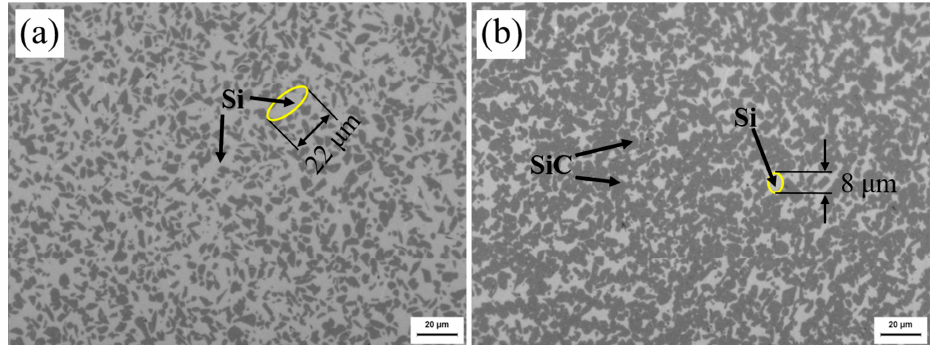
Figure 9. The microstructure of RB-SiC for: ( a ) P0F0, ( b ) P20F80. The bulk density of SiC is obviously higher than Si. Therefore, the bulk density of RB-SiC would definitely be increased with the increase in SiC content. Comparing P10F90 with P0F0, the impregnation method increased the density of RB-SiC by 6.6%. When the concentration of PF was 20 wt.%, the density of P20F80 reached the maximum with a value of 2.94 g/cm 3 . However, the bulk density of P30F70 was only 2.86 g/cm 3 , as shown in Fig- ure 10a. Due to the limited solubility of PF in FA, when the concentration of PF was 30 wt.%, the viscosity of the composite precursor solution was increased, and the efficiency of impregnation was reduced. The density of RB-SiC was consistent with that of the po- rous preform, as shown in Figures 4 and 10a. The apparent porosity is one of the key factors affecting the mechanical properties of ceramics. In the development of precision ceramics, the apparent porosity should be reduced as much as possible. The pores on the surface of RB-SiC lead to stress concentration. As the stress increases, cracks will be